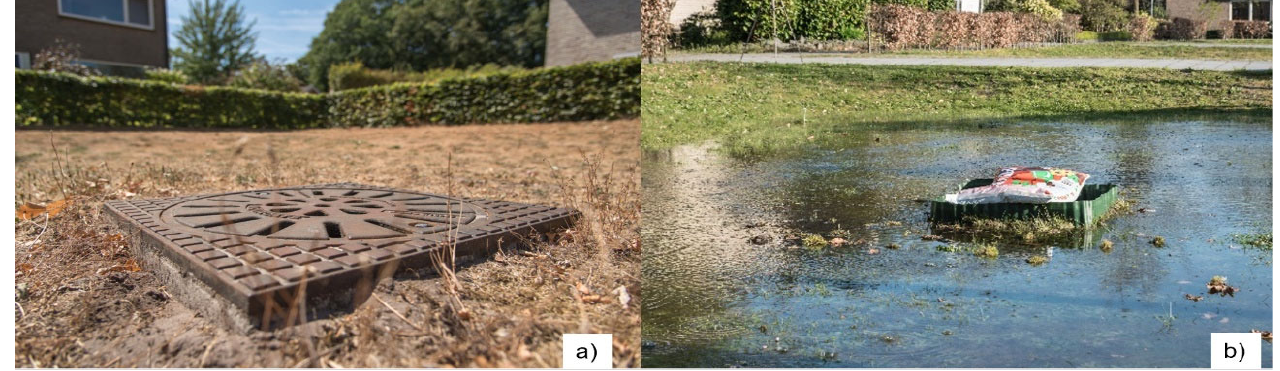
Figure 4. Inlet of the swale in Dalfsen—( a ) dry period in 2018, ( b ) during full ‐ scale test in 2017. The dimensions of the swales are presented in Figure 5. All swales have a maximum depth of 50 cm to street level. Swales 1 and 2 are similar (both an average storage volume 7.6 m 3 up to the overflow level of appr. 10 cm height); swale 3 is smaller (storage volume 1.7 m 3 up to the overflow level).